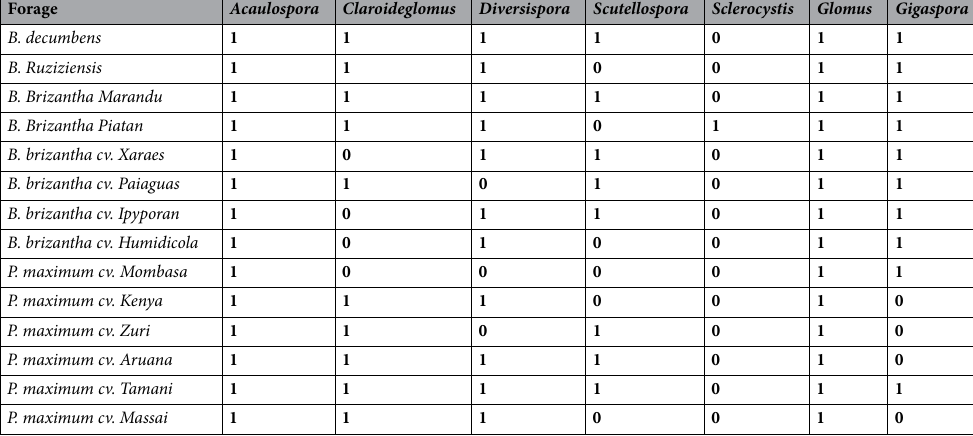
Table 2. Presence (1) and absence (0) of genera of arbuscular mycorrhizal fungi associated with the rhizosphere of different forage grasses in Cerrado soil.